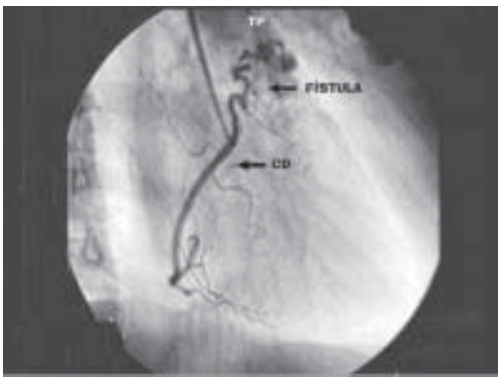
Fig. 1B - Pre-operative angiography demonstration a right coronary artery (CD) fistula to the pulmonary branch.